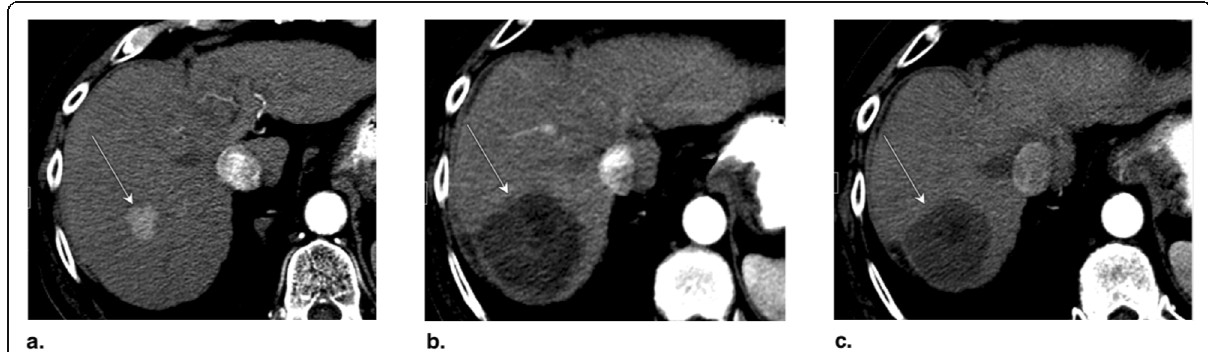
Fig. 14 Axial CT in late arterial phase obtained ( a ) pretreatment: image shows nonrim arterial phase hyperenhancement (APHE) of a 2-cm observation in segment VII (arrow). b 6 weeks post microwave ablation (MWA): image shows large hypodense cavity (arrow) with margins covering the targeted lesion. c 6 months post MWA: image shows well-defined cavity (arrow) with decreased diameter and no APHE. The